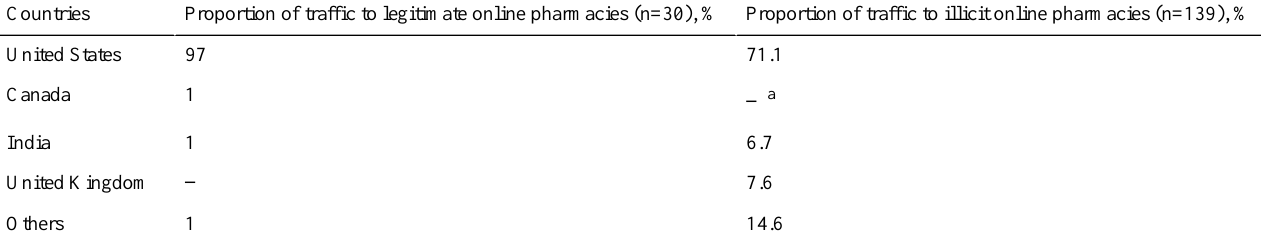
Table 5. Traffic from different countries to online